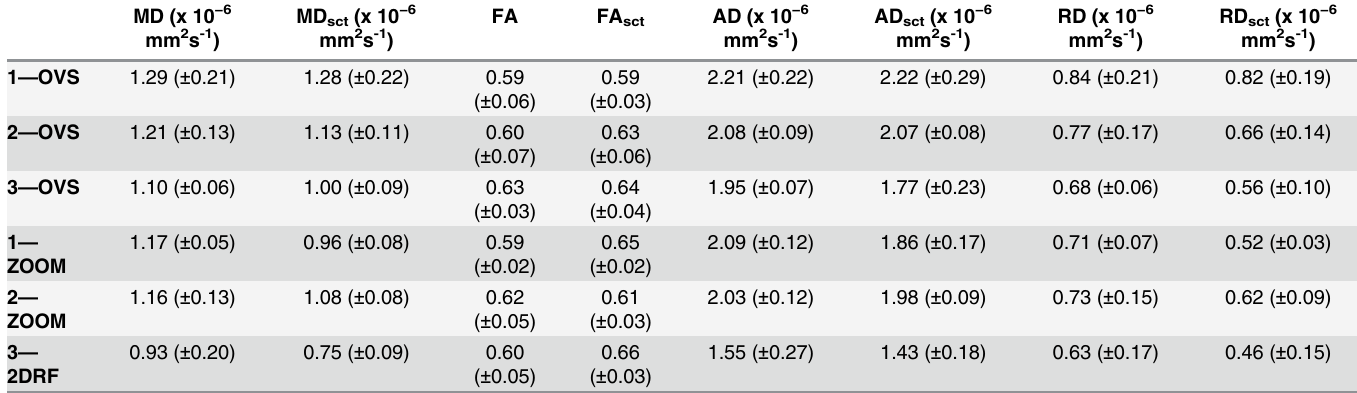
Table 3. Cervical cord (C1-C6) mean MD, FA, AD and RD values ( ± SD) for each site and protocol, given both for the manual ROI analysis performed in native space and also using automatic analysis with the SCT (with subscript ‘ sct ’ ). MD (x 10 − 6 mm 2 s -1